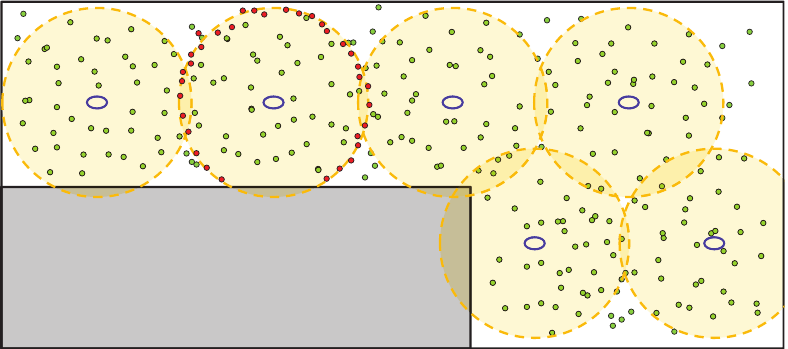
Figure 4. Example of particle initialization (green dot: general PF; red dot: